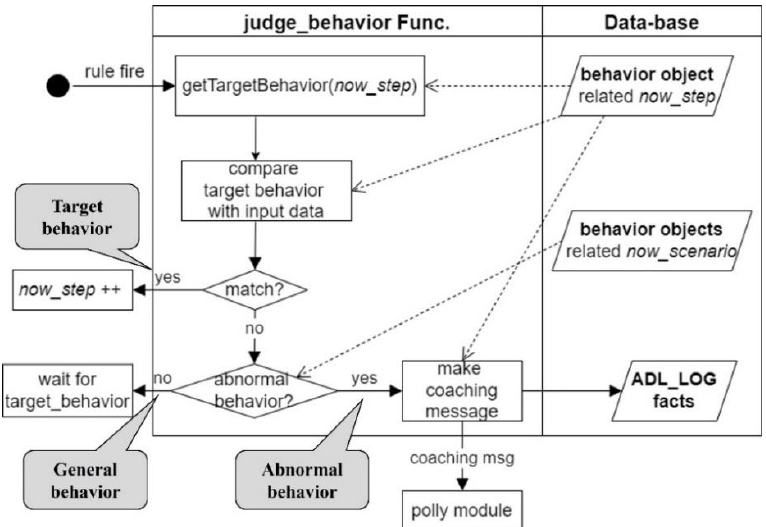
Figure 12. Flowchart showing the process after determining the suitability of the user’s behavior in the “judge_behavior” function.